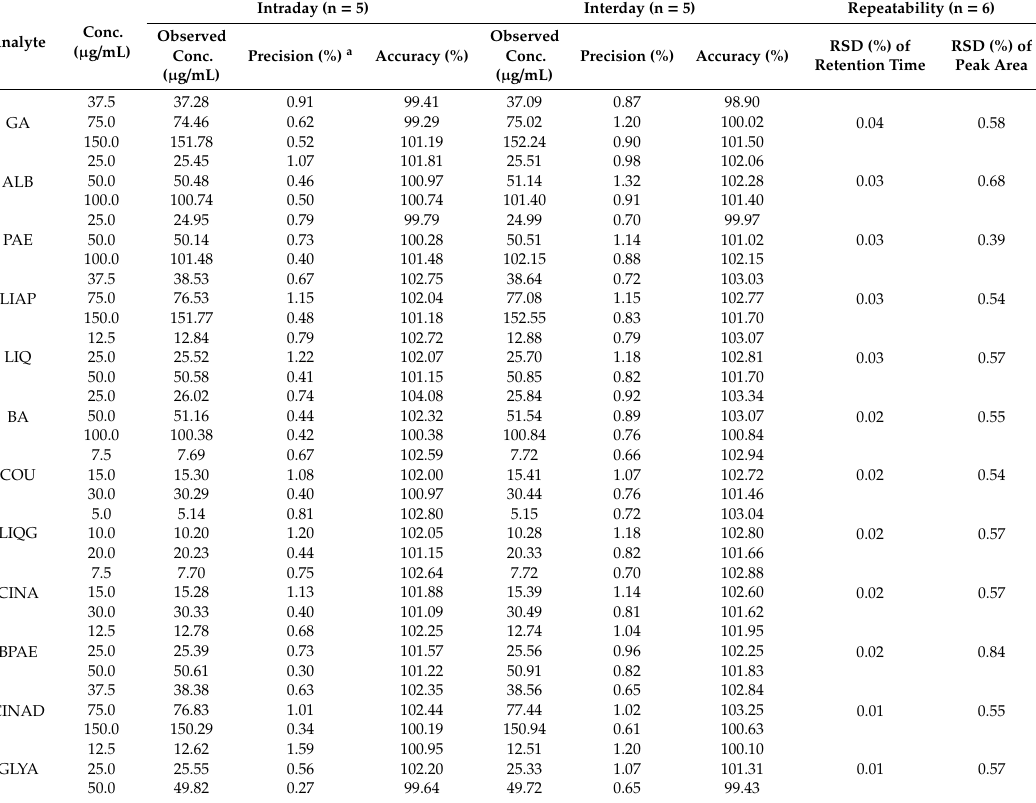
Table 3. Precision of the analytical method for the 12 marker analytes in